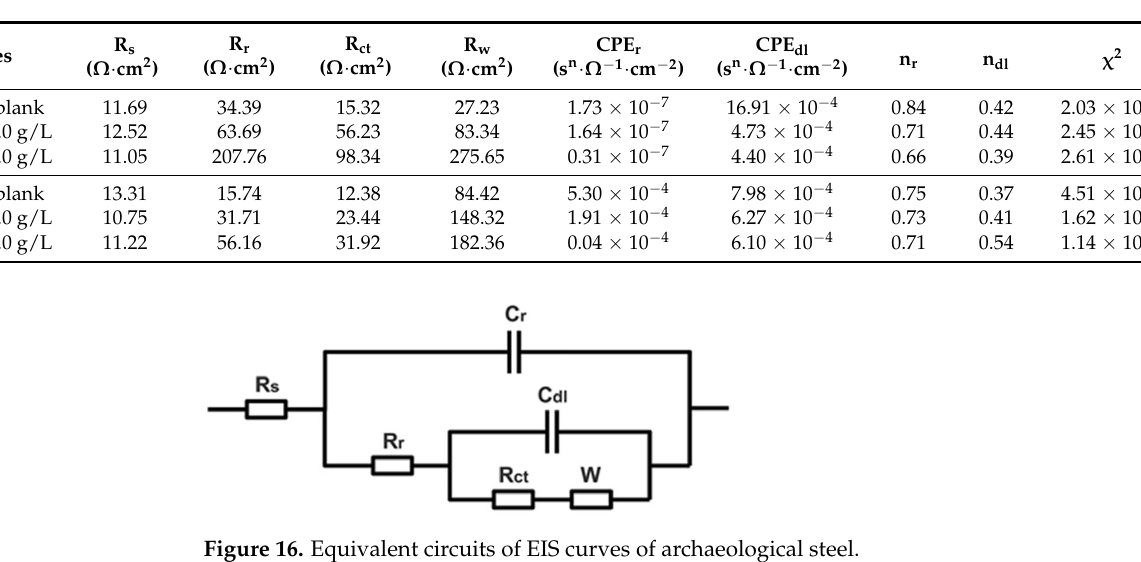
Table 1. Fitting parameters of EIS curves of archaeological steel.